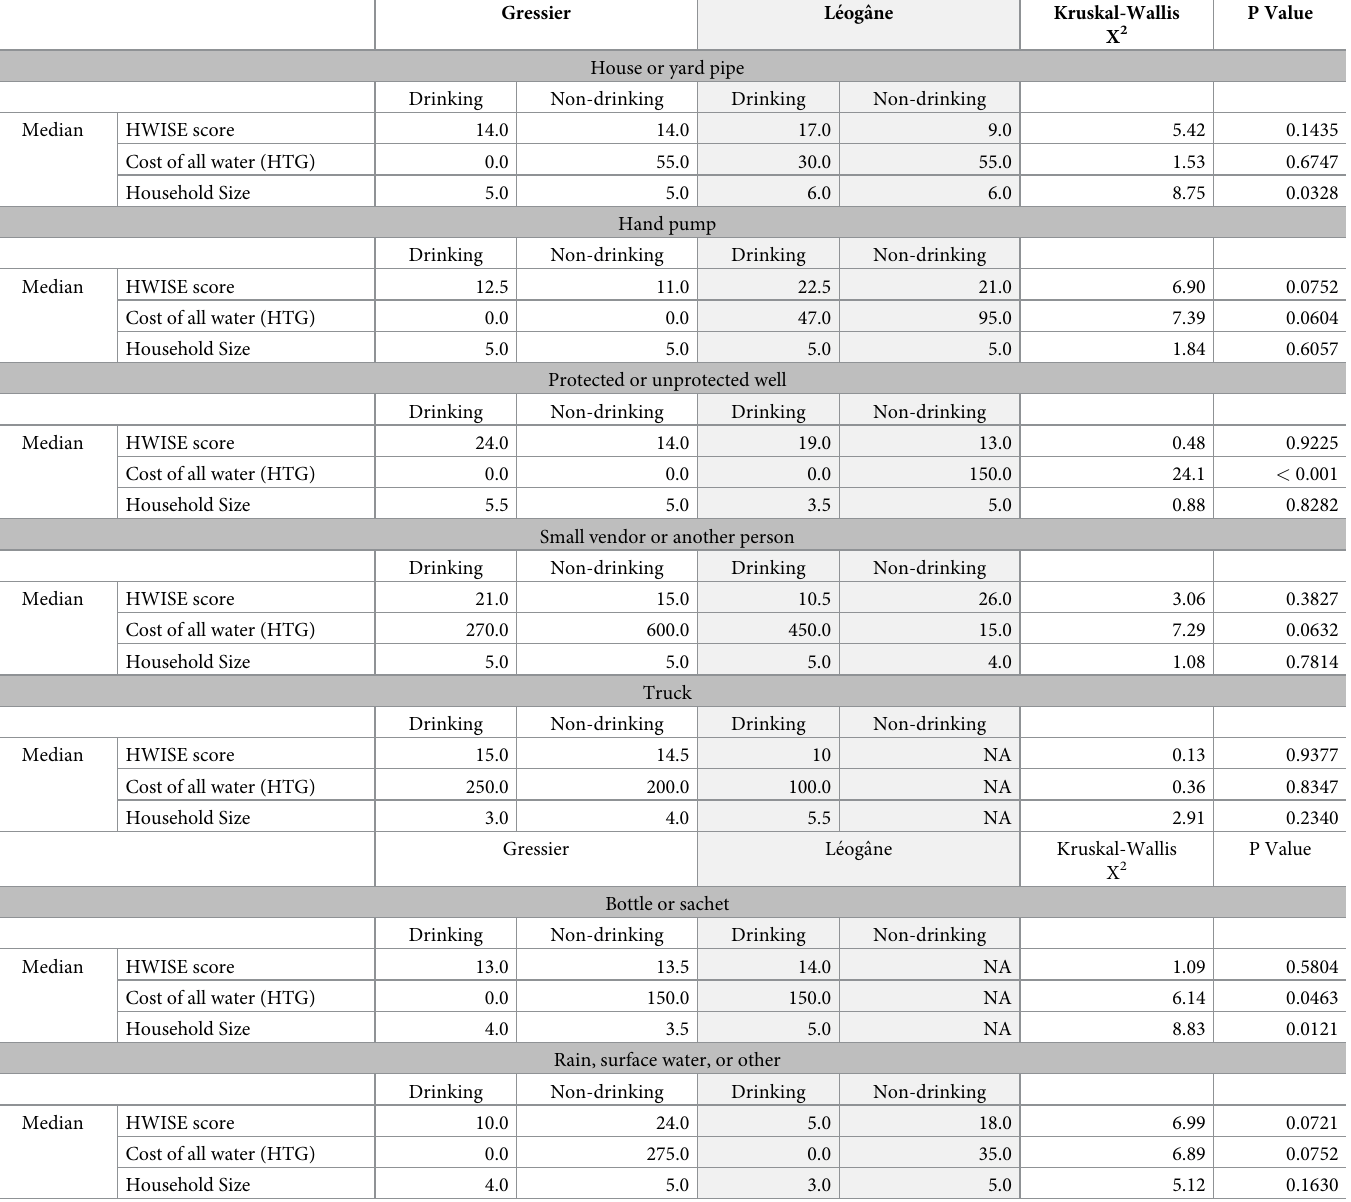
Table 2. Differences in numeric measures between drinking and non-drinking sources and locations (Kruskall-Wallis).